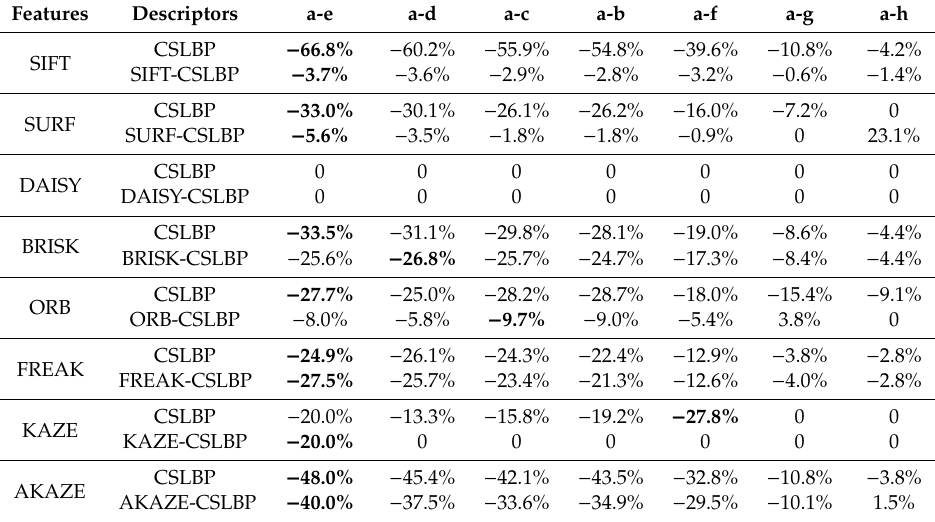
Figure 14. Matching results of the precision of Boat sequence for the eight original, the CSLBP, and the combined descriptors. The X label represents the matched images of Boat sequence, and the Y label denotes the precision for each descriptor. ( a ) SIFT features; ( b ) SURF features; ( c ) DAISY features; ( d ) BRISK features; ( e ) ORB features; ( f ) FREAK features; ( g ) KAZE features; and ( h ) AKAZE features. Table 5. The reduced values of recall for the CSLBP and the combined descriptors compared to the original descriptors of Boat sequence.